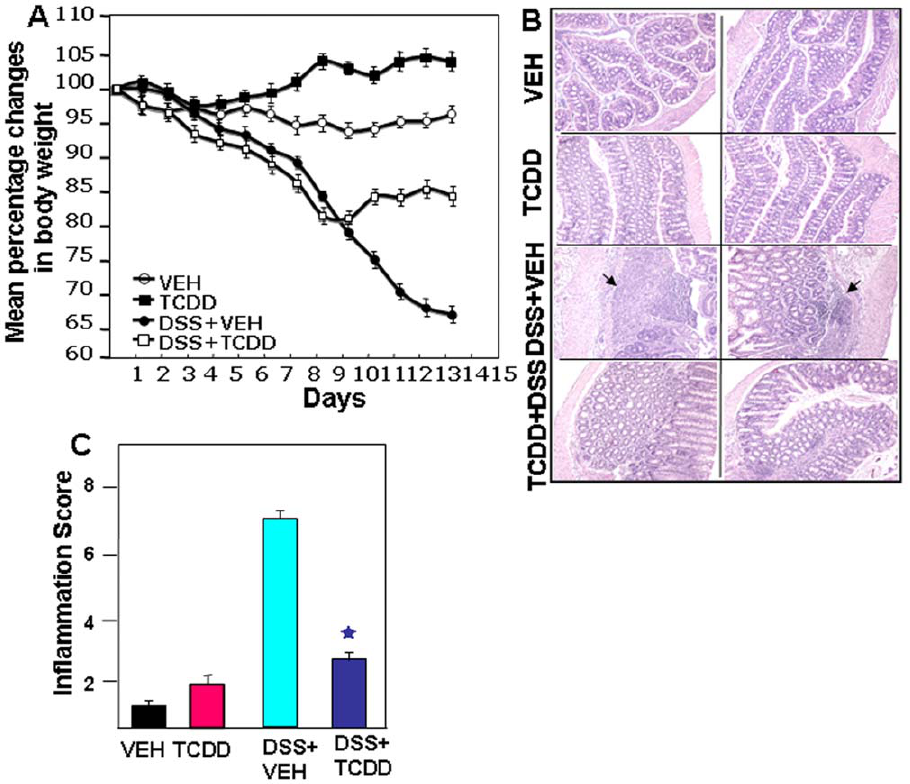
Figure 1. Change in body weight, histological characterization, and severity of colitis in mice after DSS induction and TCDD treatment. A. We used 4 groups of C57BL/6 mice: those that received VEH alone, TCDD (25 m g/kg body weight) alone, DSS + VEH, or a combination of DSS + TCDD. In DSS mice, TCDD was given as a single dose on the first day of DSS exposure. After seven days, DSS was replaced with a water cycle ( ad libitum ) for another seven days. The body weight of the mice was recorded daily. The statistical significance difference between each groups were assessed by using Mann-Whitney U Test. Data represents the mean of three experiment involving 6 mice per group. There was statistically significant difference between DSS + VEH vs DSS + TCDD groups (p , 0.05). B. Histological sections of colons from the 4 groups of mice, DSS + VEH-treated mice showed significant lymphocyte infiltration and distortion of glands, while DSS + TCDD-treated mice showed colon lumen having markedly decreased lymphocyte infiltration. Other pathologic changes during DSS-induced colitis included diffuse leukocyte infiltrates, distorted crypts, and thickening of the lamina propria in the area of distorted crypts in the colon (B). These changes were significantly reversed in DSS + TCDD groups as seen in inflammation score (C). Asterisks indicate statistically significant differences; i.e., p , 0.01 between DSS + VEH versus DSS + TCDD treated